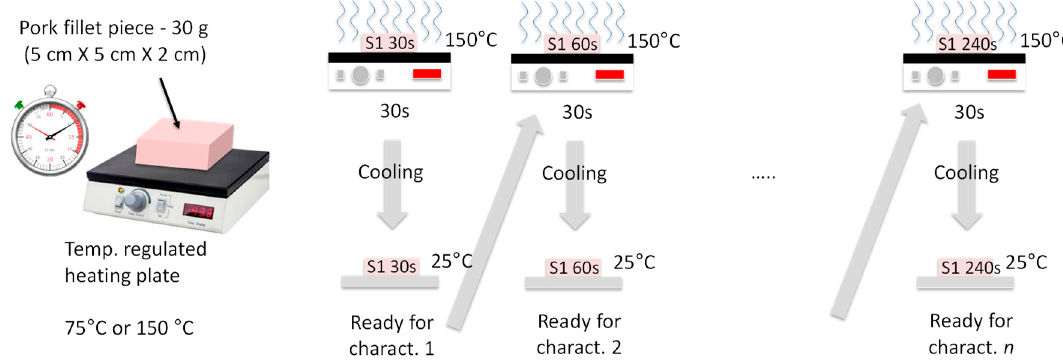
Figure 3. Interrupted sample-heating procedure (IHP).